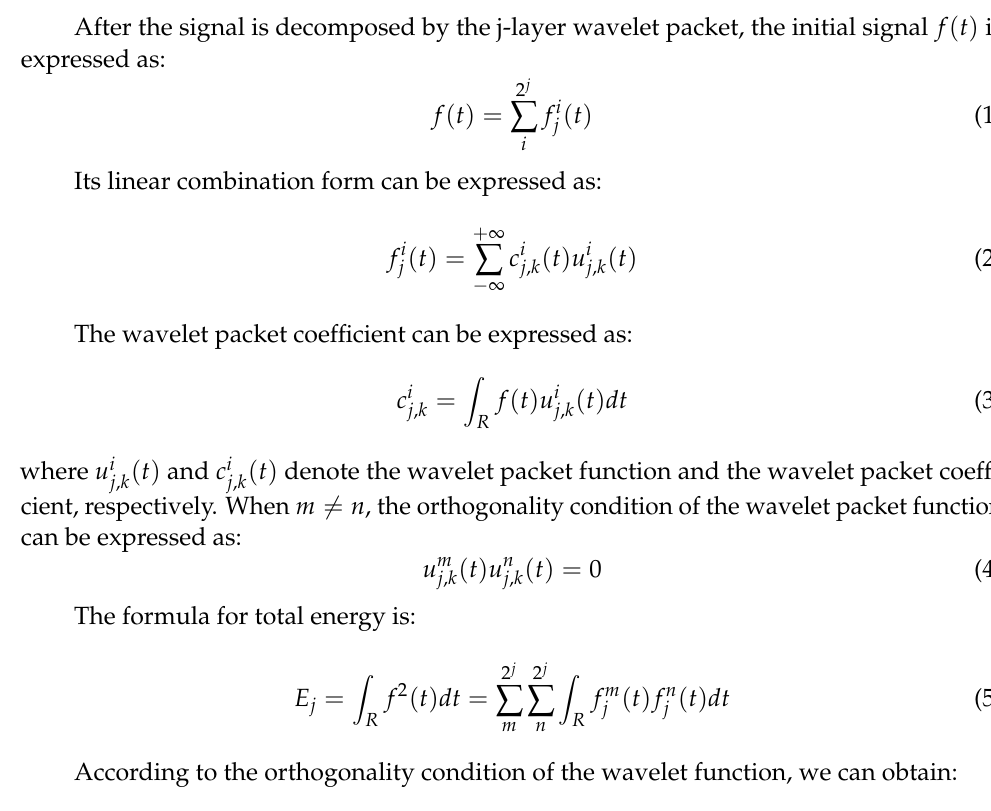
Figure 1. Three-layer WPD tree.